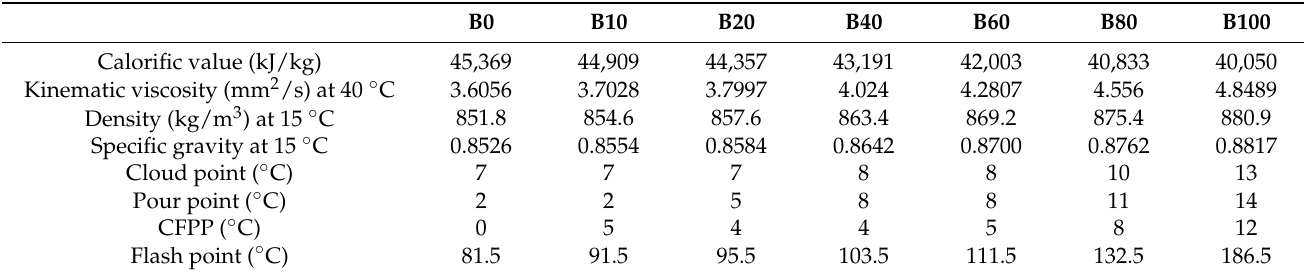
Table 4. Fuel properties of Neem biodiesel-diesel blends by DT method.